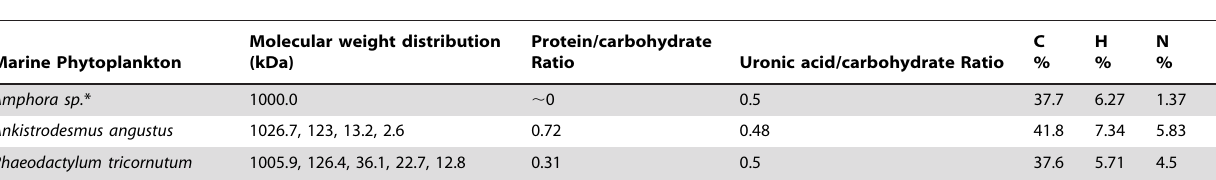
Table 1. Chemical analysis of